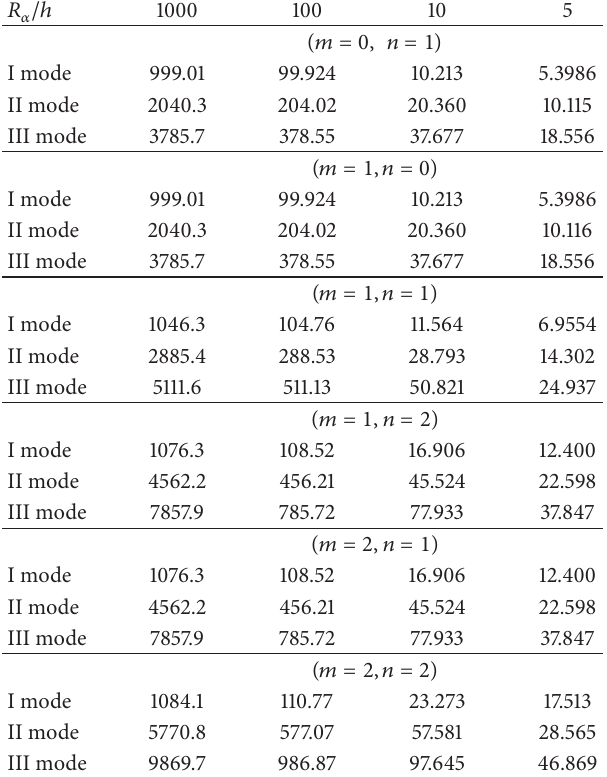
Table 13: Benchmark 9. Simply supported isotropic spherical shell panel. First three vibration modes in terms of no-dimensional circular frequency 𝜔 = 𝜔(𝑎 2 /ℎ)√𝜌/𝐸 for several combinations of half-wave numbers 𝑚 and 𝑛 . 𝑀 = 100 fictitious layers and 𝑁 = 3 order of expansion for the exponential matrix.